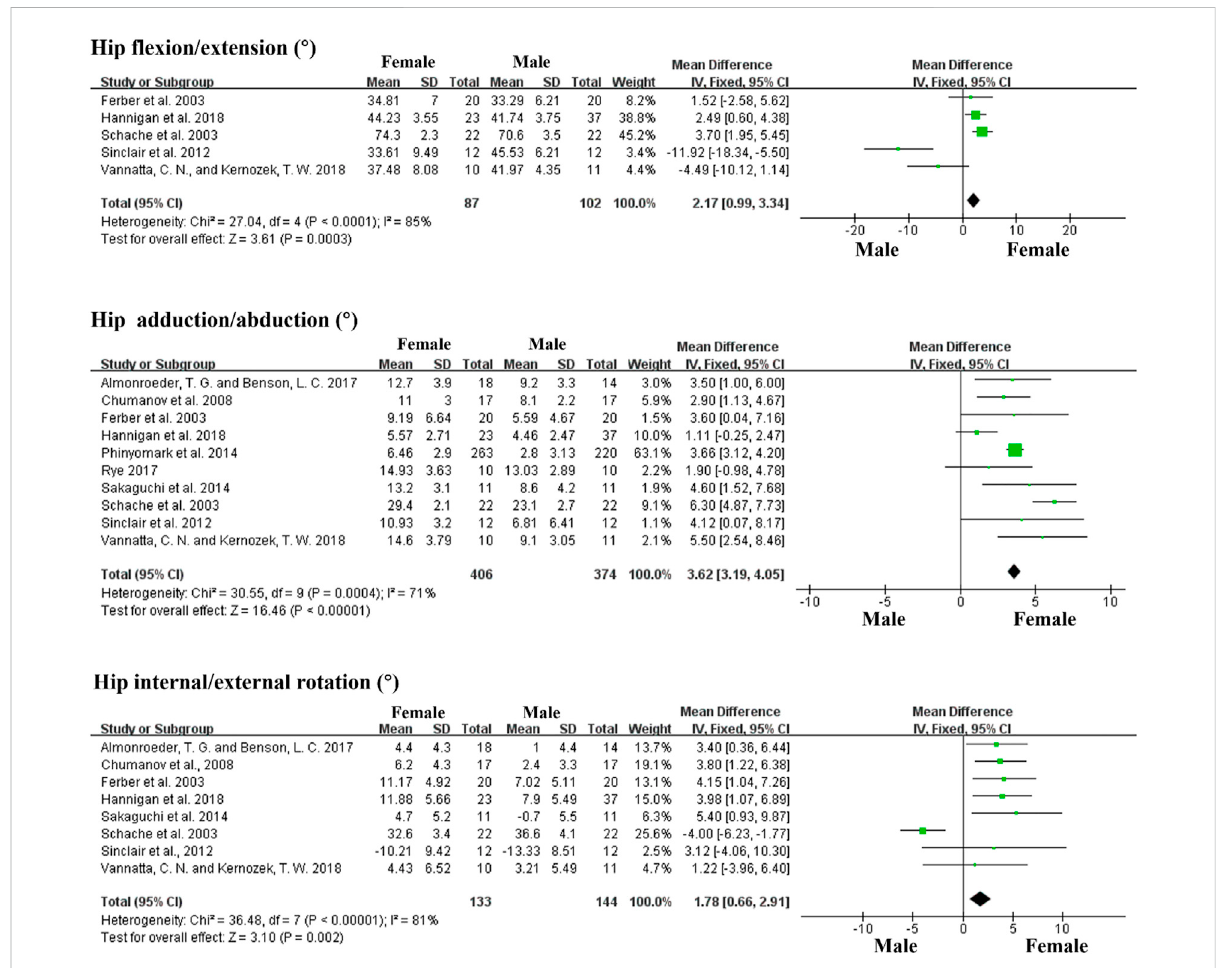
FIGURE 2 Forest plots displaying a kinematic comparison of the hip joint between female and male runners during